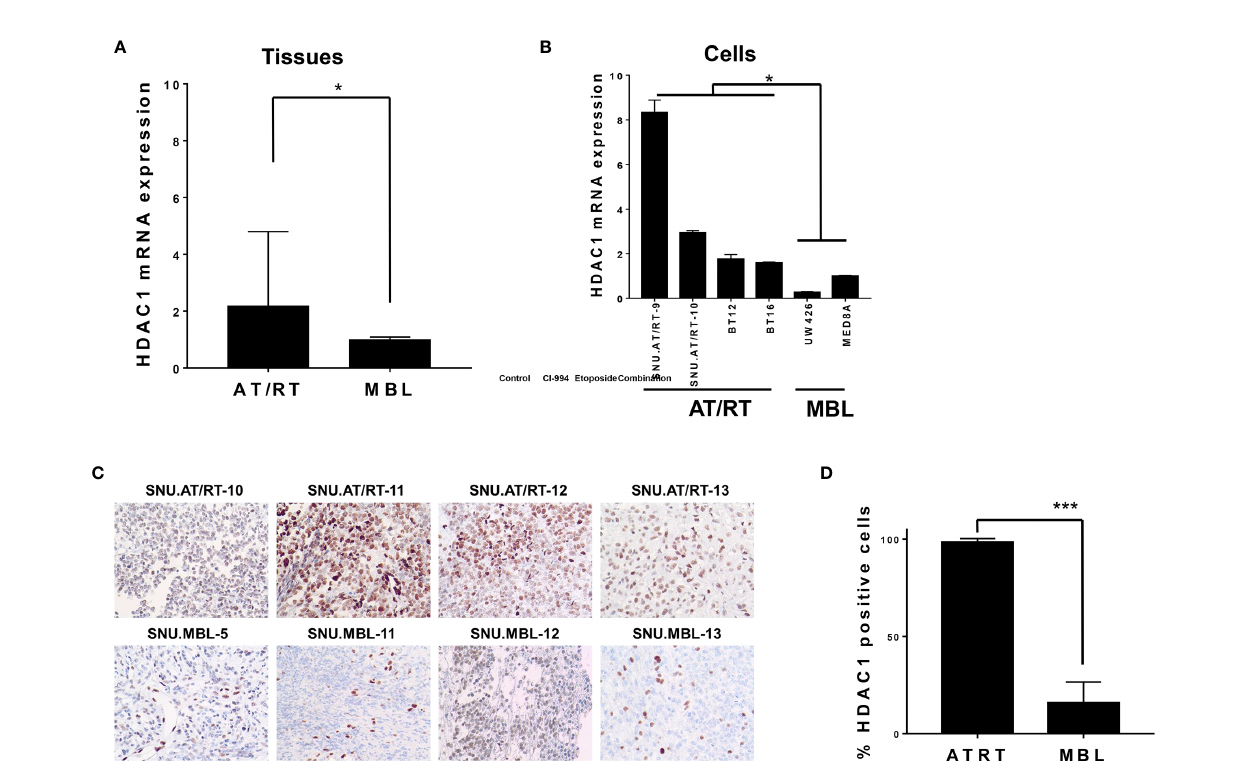
FIGURE 1 | HDAC1 expression in AT/RT samples compared to MBL samples. (A) The quantitative polymerase chain reaction (qPCR) showed that HDAC1 mRNA expression in AT/RT tissues was 2.19 (p = 0.027) folds higher than in MB tissues. (B) HDAC1 mRNA level was tested in 3 AT/RT primary cultured cells(SNU.AT/RT- 5, SNU.AT/RT-9, SNU.AT/RT-10) and each established AT/RT (BT12, BT16) and MB (UW426, MED8A) cell lines. HDAC1 is signi fi cantly overexpressed in AT/RT samples compared to the lowest expression level in UW426, one of MB cell lines. (C) IHC results show signi fi cantly higher HDAC1 protein expression in AT/RT compared to medulloblastoma. (D) The graph shows the percentage of HDAC1 positive cells in IHC (p < 0.0001). *p < 0.05, ***p <